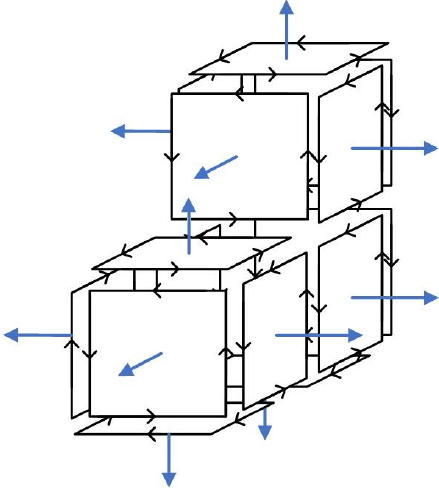
Figure 4. Voxel model construction.